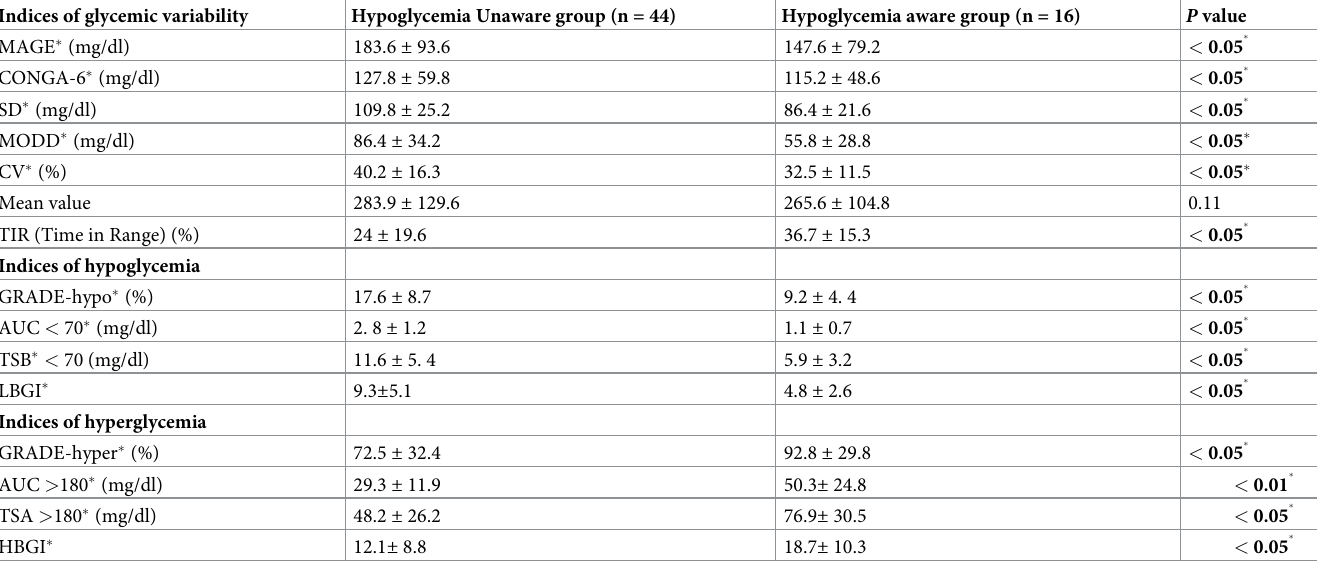
Table 2. Glycemic variability indices in patients with FCPD and hypoglycemia awareness and unawareness. Indices of glycemic